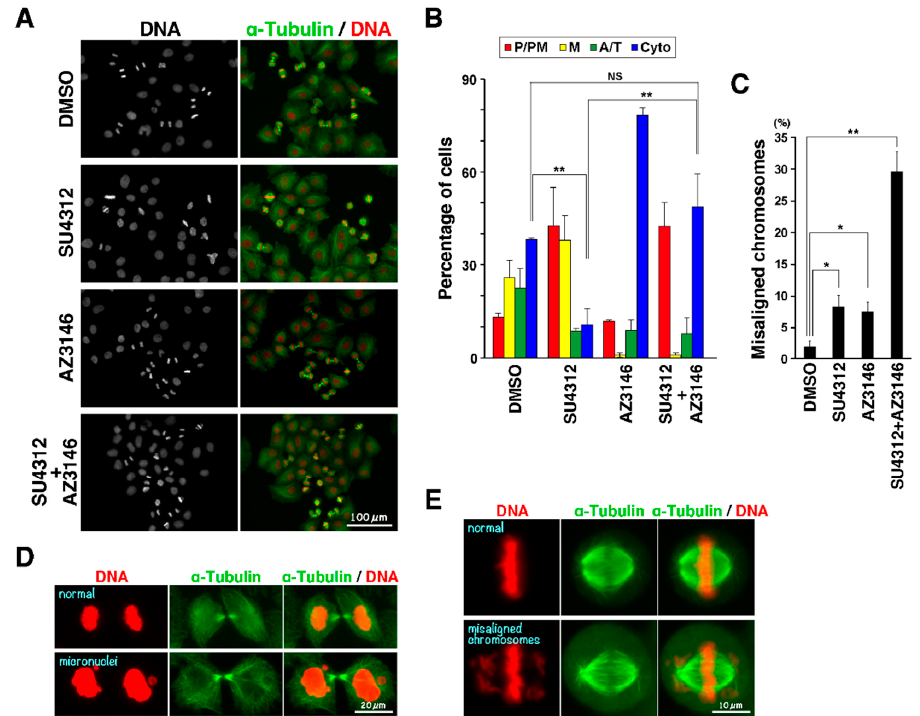
Figure 6. Activation of the spindle assembly checkpoint in SU4312-treated cells. Cells were treated with 6 µM RO-3306 for 20 h. After release from RO-3306 treatment, the cells were incubated with 10 µM SU4312, 2 µM AZ3146, or a combination thereof for 60 min. The cells were fixed with 4% formaldehyde, and stained for α -tubulin and DNA. ( A ) Representative images are shown. Scale